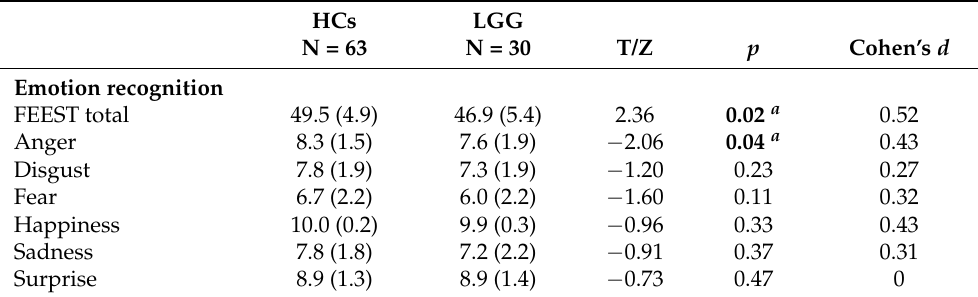
Table 2. Comparison between LGG patients and healthy controls on tests for emotion recognition at T1.